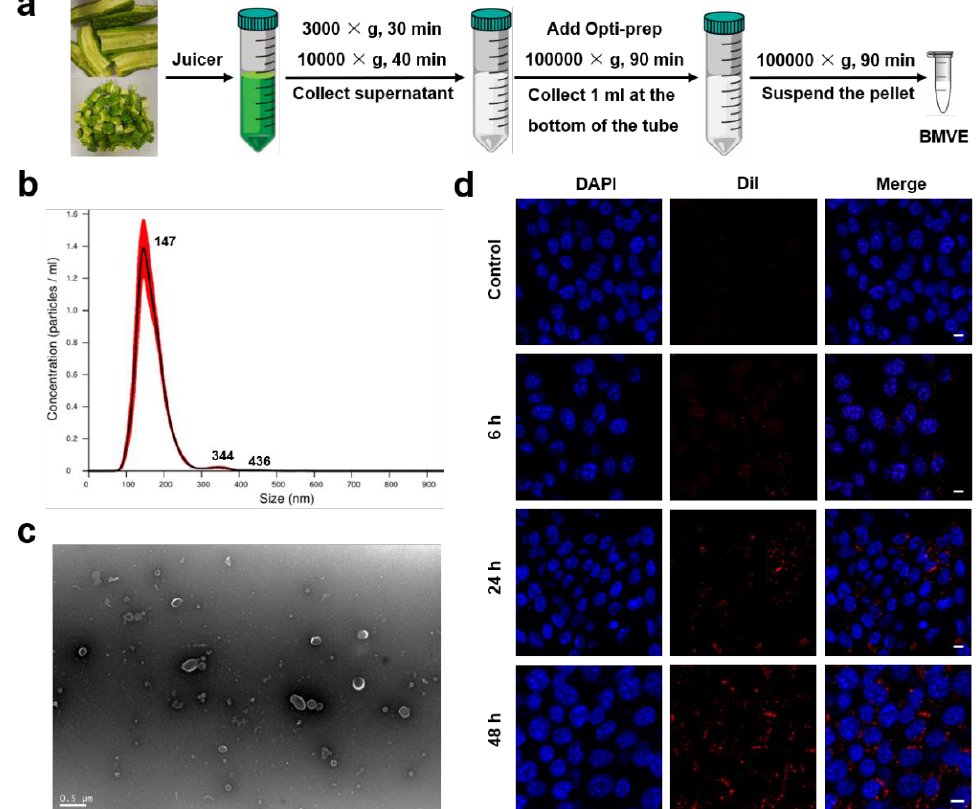
Figure 1. Isolation, characterization and cellular internalization of BMVE. ( a ) A schematic illustration of the isolation method for BMVE from bitter melon. ( b ) NTA of BMVE concentration and size distribution. ( c ) TEM image of isolated BMVE (scale bar = 0. 5 μm). ( d ) 4T1 cells were treated with 20 μg /mL Dil (red)-labeled BMVE for 0, 6, 24 and 48 h, while the nuclei were stained with DAPI (blue). The internalization of BMVE by 4T1 cells was imaged by confocal microscopy (scale bar = 10 μm).